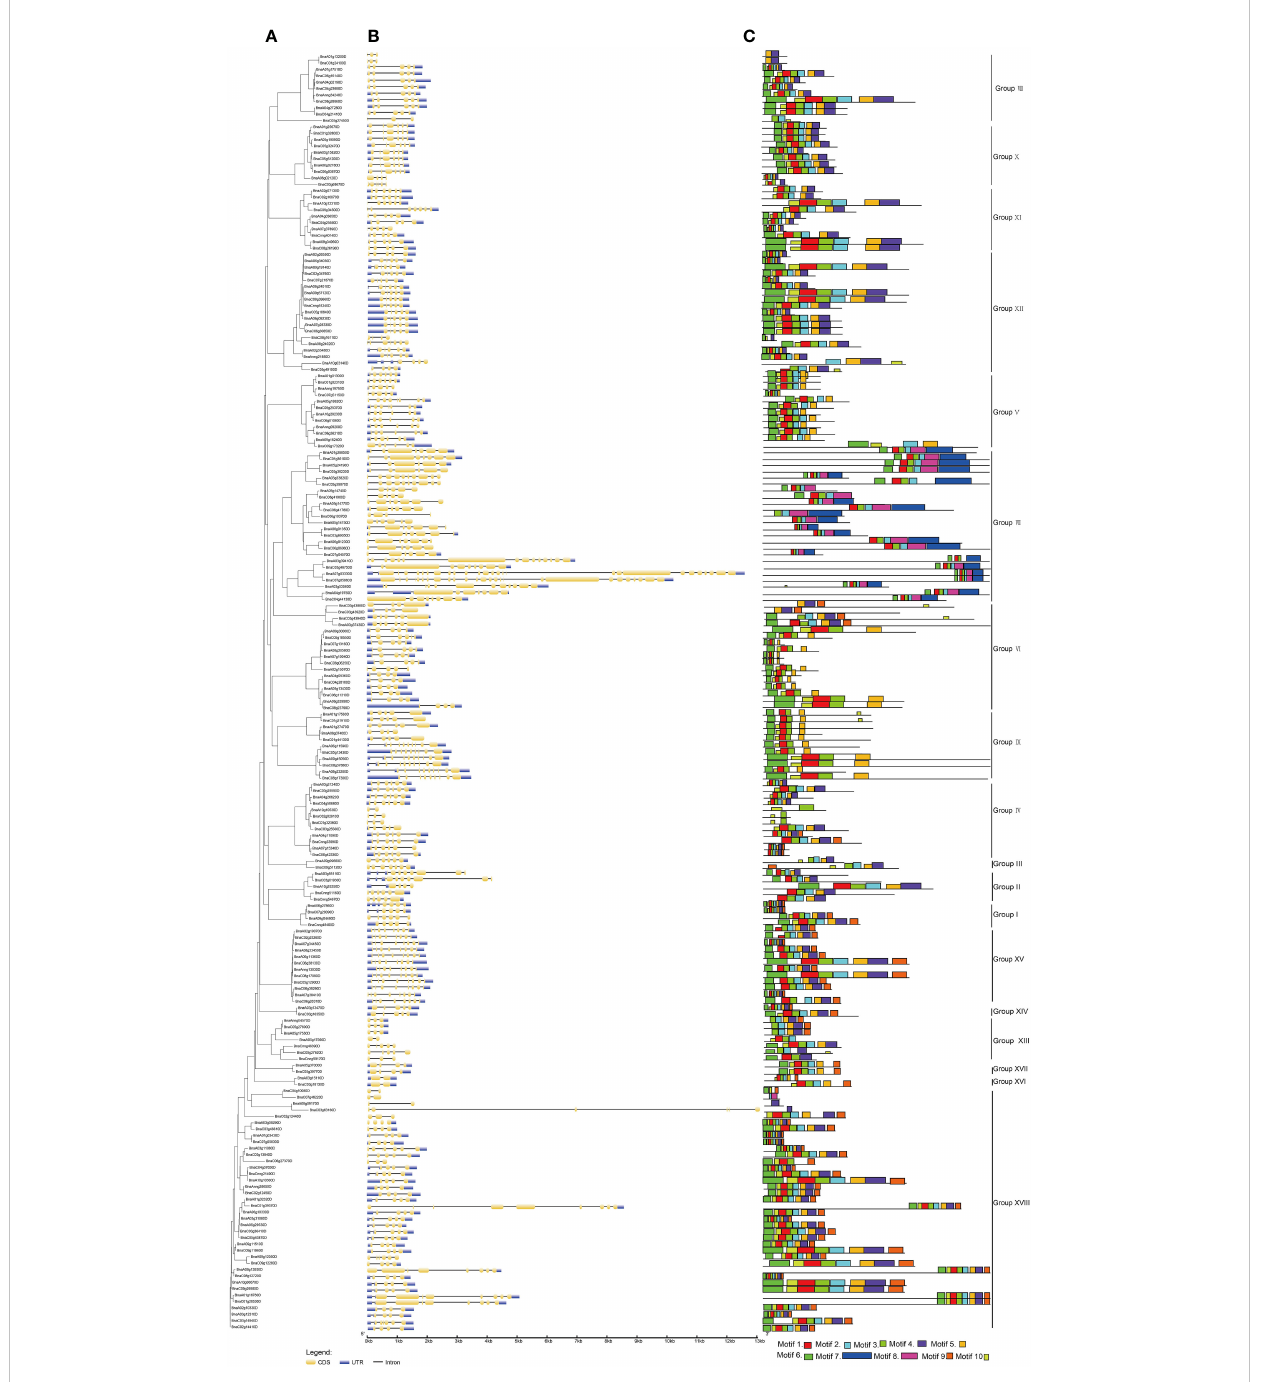
FIGURE 3 Gene structure and motif analysis of B. napus UBC genes according to their phylogenetic relationships. (A) Phylogenetic analysis. (B) Gene structures of BnUBC s. Yellow and blue- fi lled boxes represented CDS and UTR, respectively. Black lines indicated introns. (C) Conserved motifs in BnUBC proteins were detected by MEME